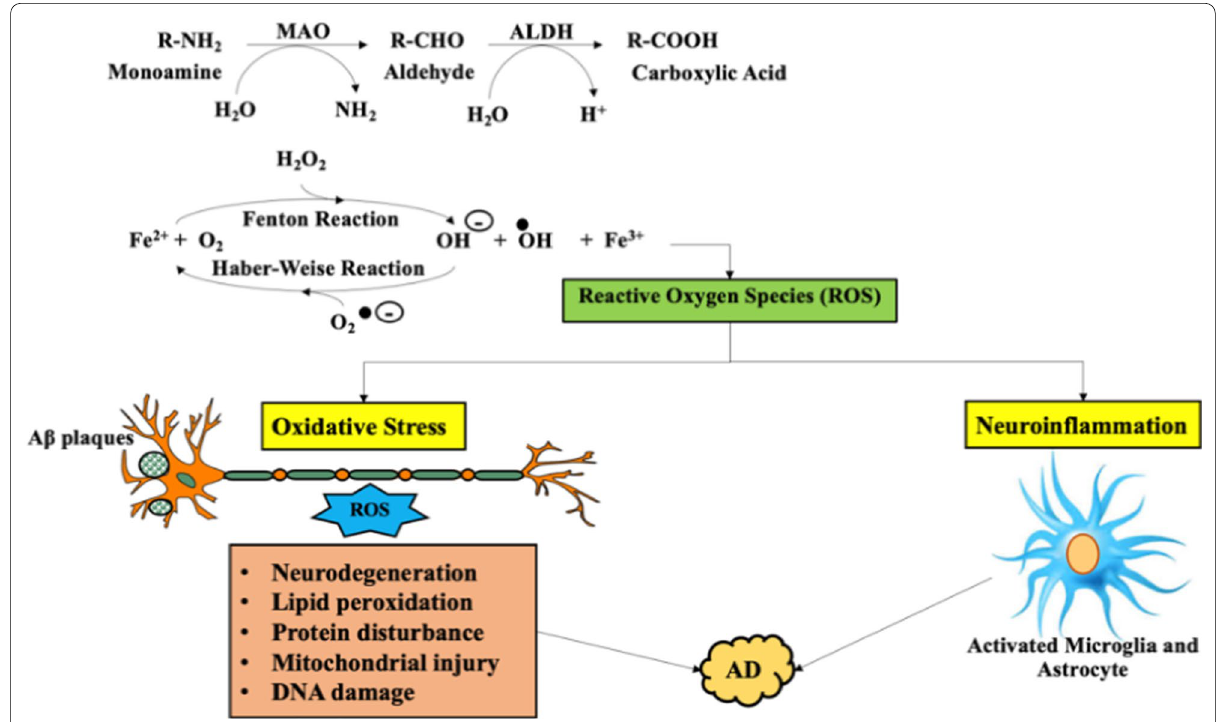
Fig. 1 Mechanism of reaction between MAO-B and Alzheimer